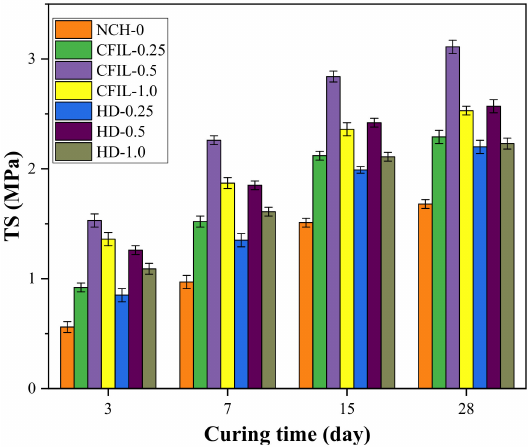
Figure 7. Relationship between TS and curing time.